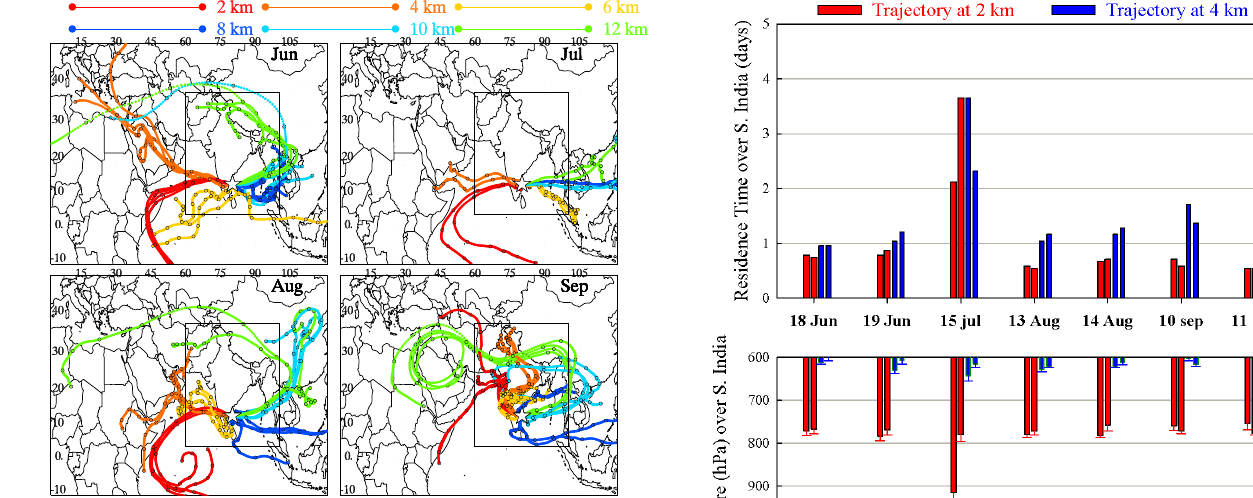
Figure 11. HYSPLIT simulated 10days backward air trajectories at 2, 4, 6, 8, 10 and 12kma.s.l. over Chennai for the CARIBIC mea- surement days. Different colors of trajectories correspond to differ- ent starting altitude over Chennai for the trajectory simulations.